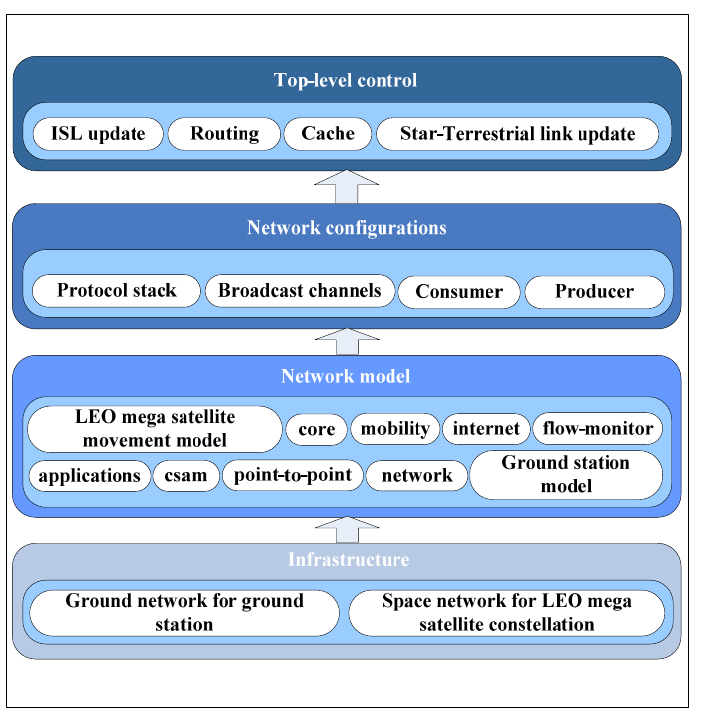
Figure 12. Architecture of the LEO mega constellation simulation platform.